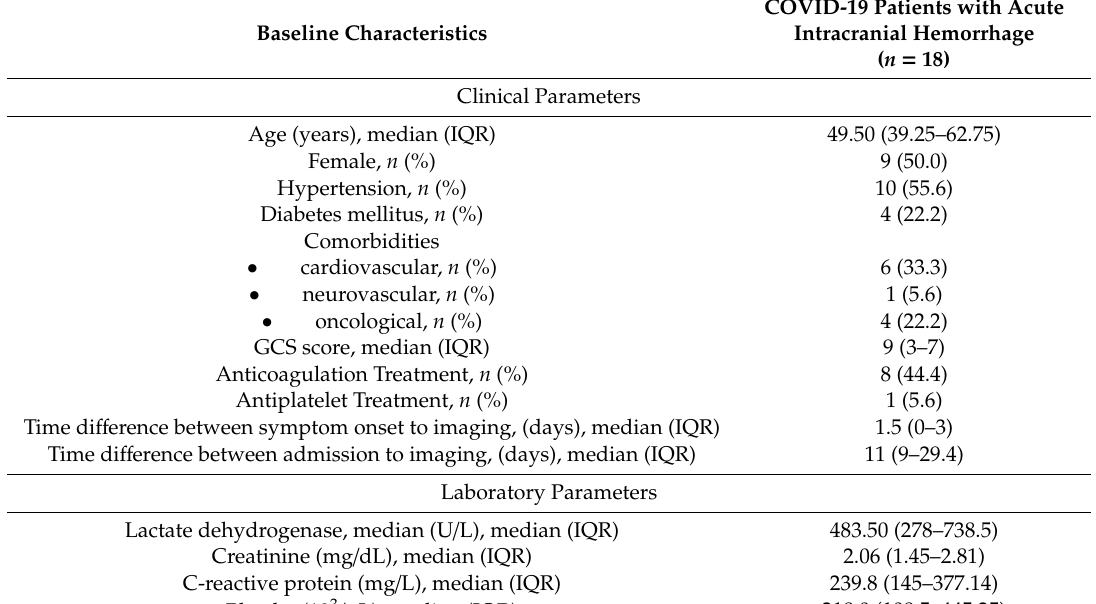
Table 1. Baseline demographic, clinical, and characteristics of patients with coronavirus disease 2019 (COVID-19).